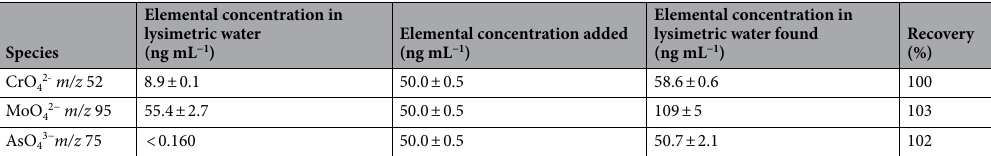
Table 3. Spike recovery test of chromate, molybdate and arsenate for lysimetric water from Tersan-P compacted geotechnical composite spiked with multielemental standard solution of oxyanions containing 50 ng mL −1 Cr, Mo and As. Concentrations in the unspiked and spiked samples were determined by simultaneous HPLC-ICP-MS speciation analysis. The results represent the average of three determinations of chromate, molybdate and arsenate with standard deviation of measurements.